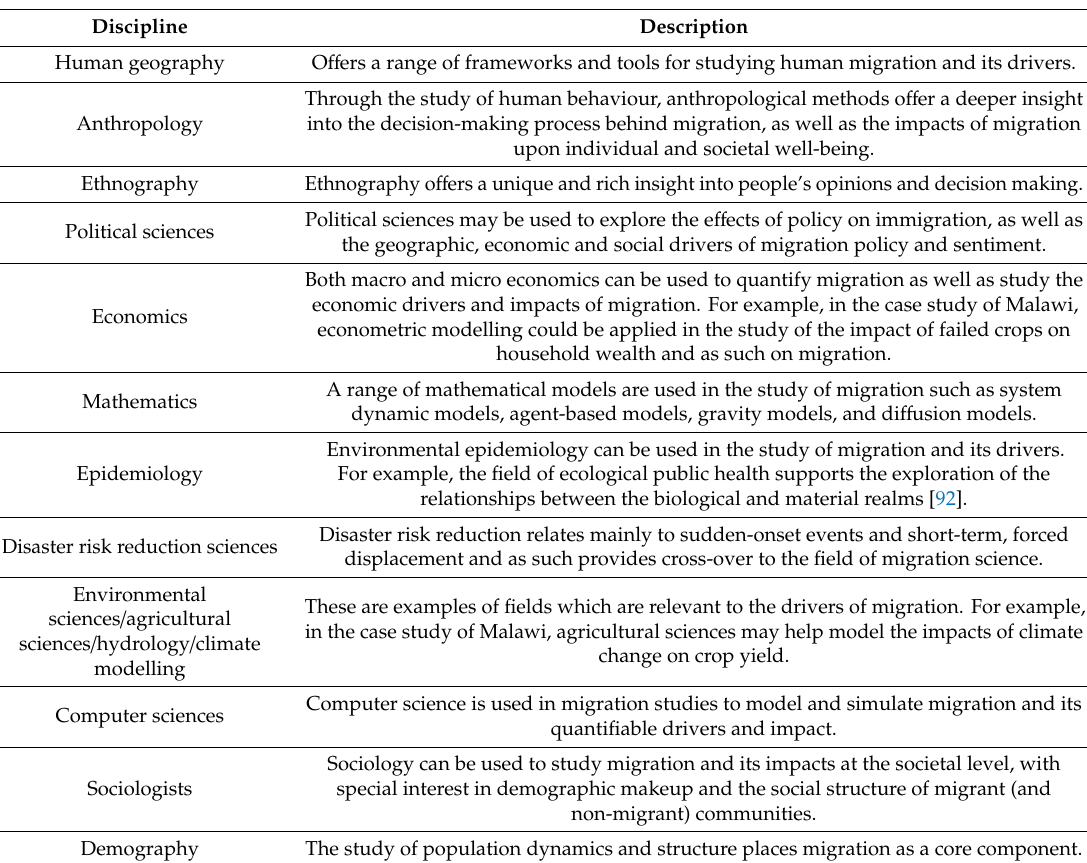
Table 4. An overview of the range of scientific disciplines which contribute to the study of climate migration, its drivers and